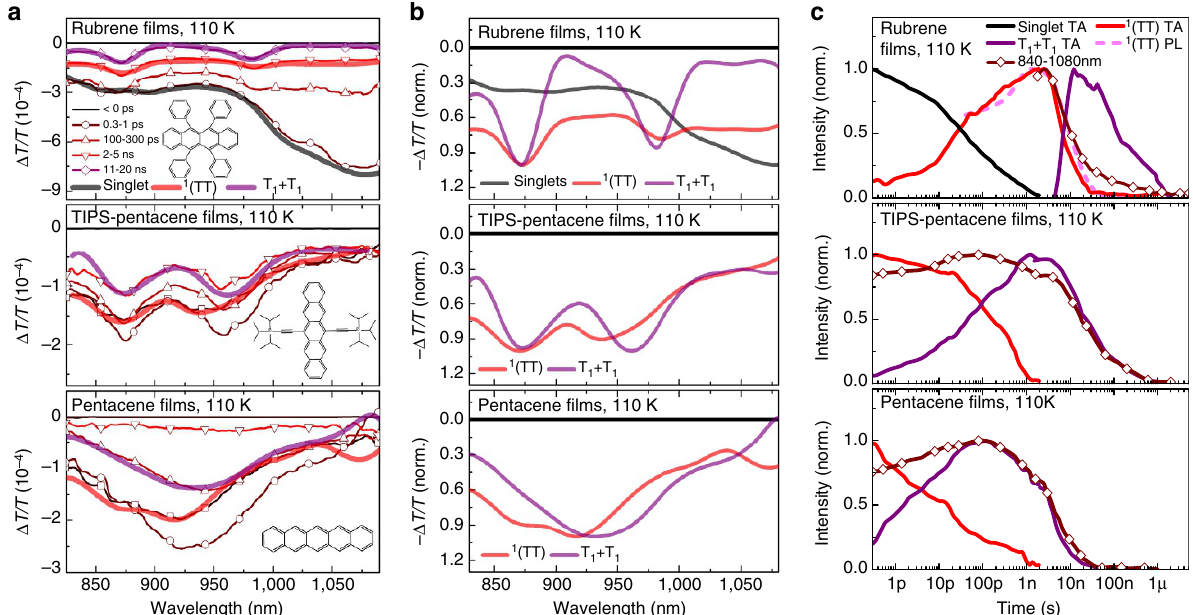
Figure 6 | 1 (TT)-mediated singlet fission in polyacenes. ( a ) TA spectra of rubrene, TIPS-pentacene and pentacene thin films measured at low temperature, averaged over the indicated delay ranges (thin lines). Spectral decomposition analysis (thick lines) provides spectra of singlet (black), 1 (TT) (red) and free triplet (purple). Note the rate of singlet fission in TIPS-pentacene and pentacene is too fast to clearly isolate singlet spectral features. In all materials, the conversion from 1 (TT) to free triplets can be identified from peak shifts in the PIA. ( b ) Extracted singlet, 1 (TT) and free triplet spectra from ( a ) normalized for clarity. ( c ) Normalized population kinetics of excited state species extracted from TA maps, along with integrated raw TA signal (brown, diamonds) and extracted PL kinetics, where applicable (dashed). All materials exhibit the same sequential